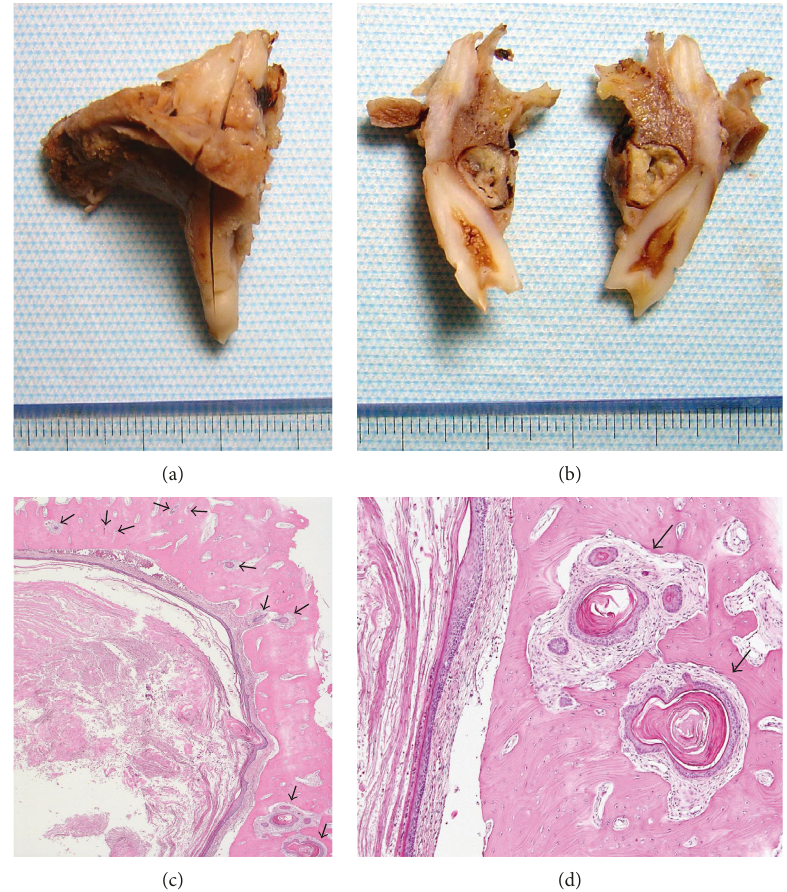
Figure 7: Macroscopic appearance and microscopic features of the additional surgically resected specimen. (a) Resected specimen. (b) Cystic lesion in the palatal side of the second premolar. (c) Microscopically, locally invasive daughter follicles in many bone marrow spaces (arrows). (d) Invasive solid cystic follicles with a KAB-like growth pattern (arrows) (HE; original magnification × 40 (c) and × 200